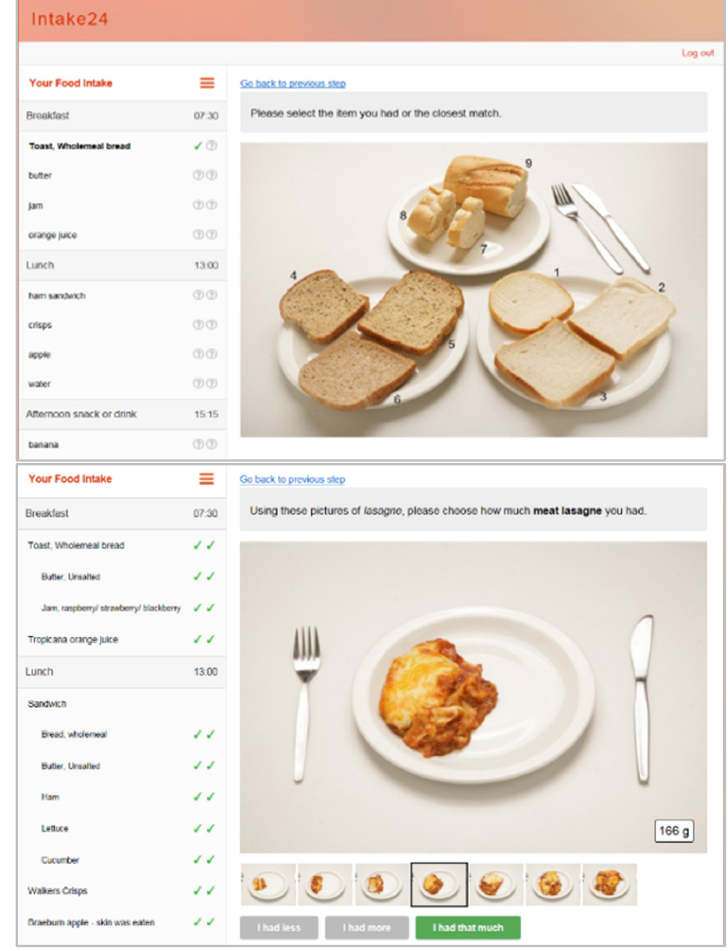
Figure 2. Examples of food portion estimation methods in